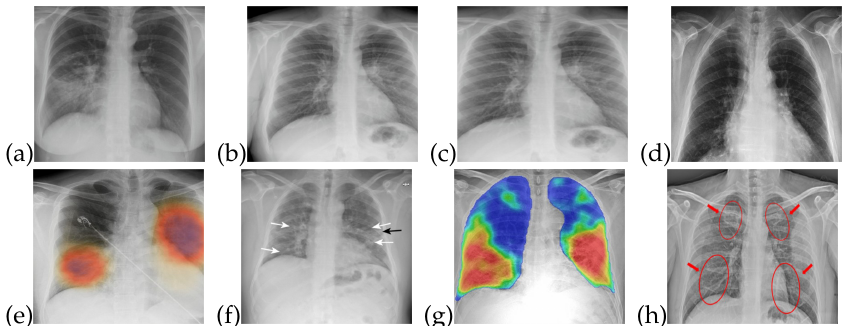
Figure 1. X-ray images for healthy and COVID-19 infected patients: ( a – d ) Normal patients X-ray ( e – h ) COVID-19 infected patients